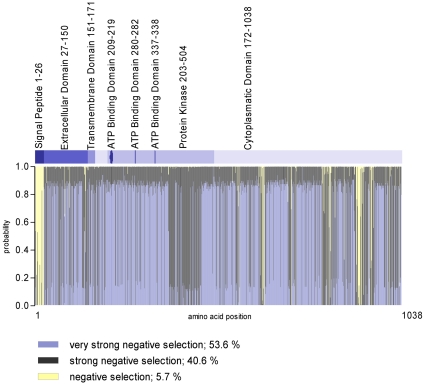
Site class probability bar plot for each codon across the BMPR2 sequence indicating strength of conservation at each amino acid position.The degree of negative selection is equivalent to the strength of conservation. Included are 36 vertebrate orthologs. Human sequence was used as reference. Genetic domains above are annotated according to http://www.uniprot.org/uniprot/Q13873. Numbers represent the location of the domains (amino acids).